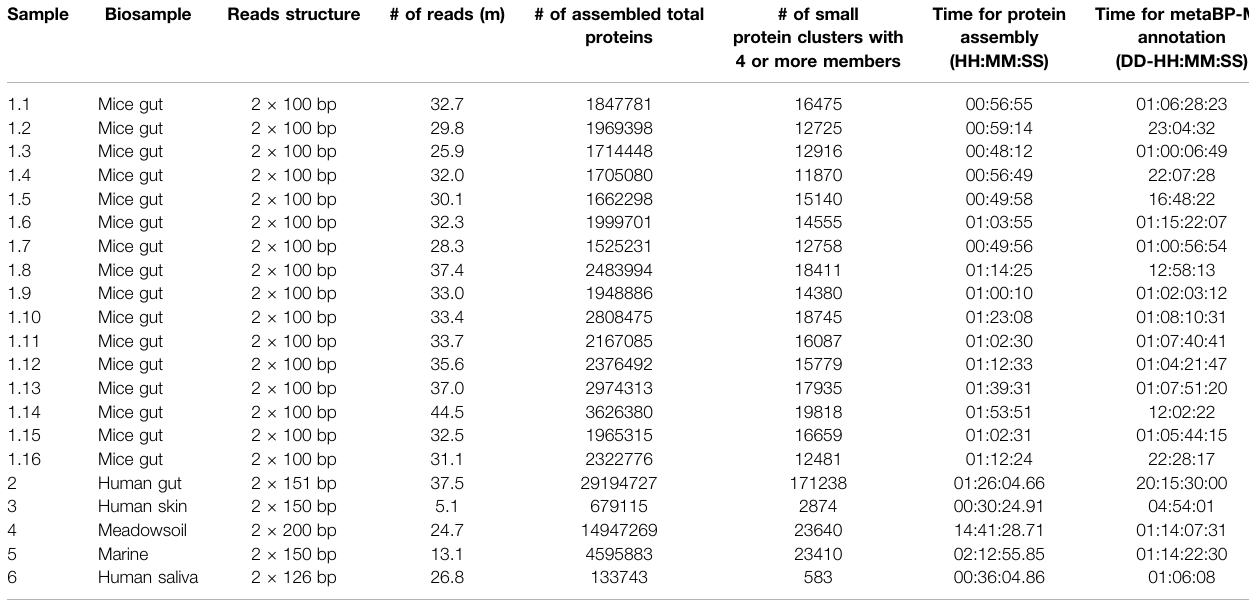
TABLE 1 | Data samples and statistics in metaBP analyses.